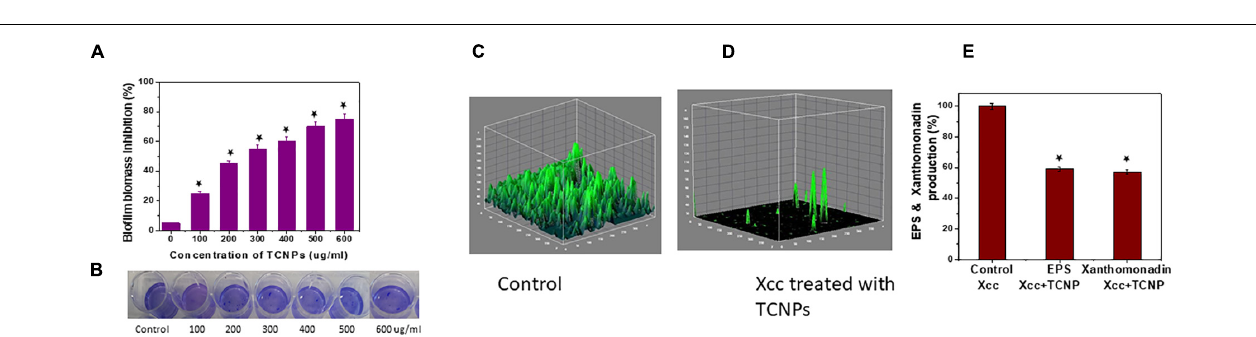
FIGURE 4 | ln vitro Biofilm inhibition of Xcc cells. (A,B) Biofilm biomass inhibition showing reduction of biofilm growth and the image of crystal violet staining plate. (C,D) Confocal images of control untreated biofilm and cells treated with TCNPs denoting reduction in growth. (E) Reduction of EPS and xanthomonadin production in control untreated cells and TCNP treated cells. Values are mean ± SD of three independent experiments, each performed in triplicates and considered statistically significant when * p < 0.05.